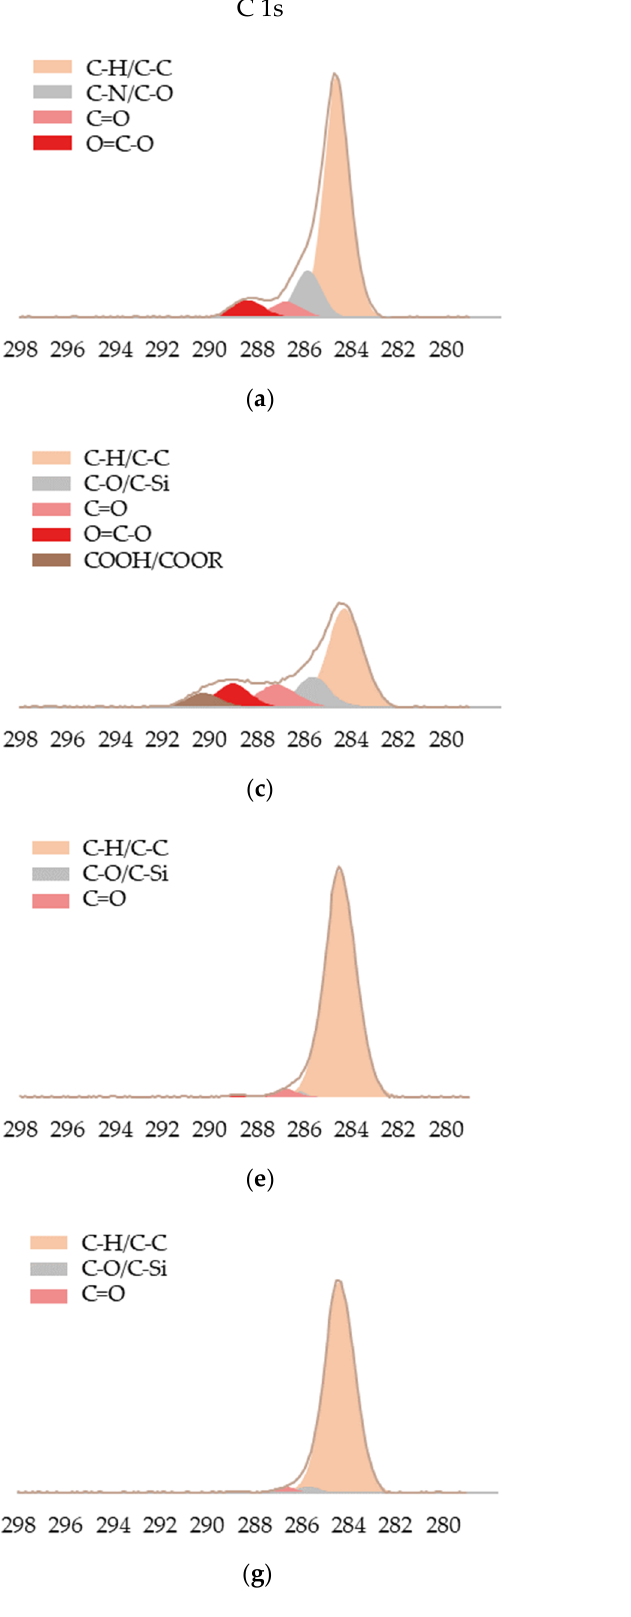
Figure 4. Deconvoluted C 1s and Si 2p peaks of HMDSO films deposited on leather samples. ( a ) C 1s of CC-0; ( b ) Si 2p of CC-0; ( c ) C 1s of CC-3; ( d ) Si 2p of CC-3; ( e ) C 1s of CC-6; ( f ) Si 2p of CC-6; ( g ) C 1s of CC-12; ( h ) Si 2p of CC-12.